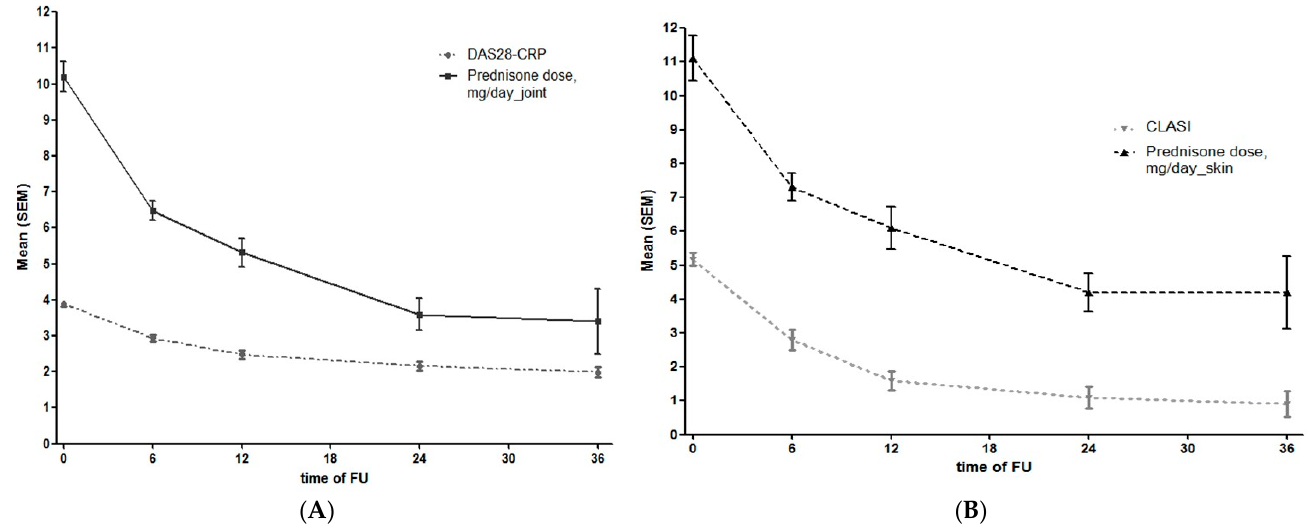
Figure 1. ( A ) DAS28 and glucocorticoid intake during the follow-up in patients with joint involvement at different timepoints. ( B ) CLASI and glucocorticoid intake during the follow-up in patients with skin involvement at different